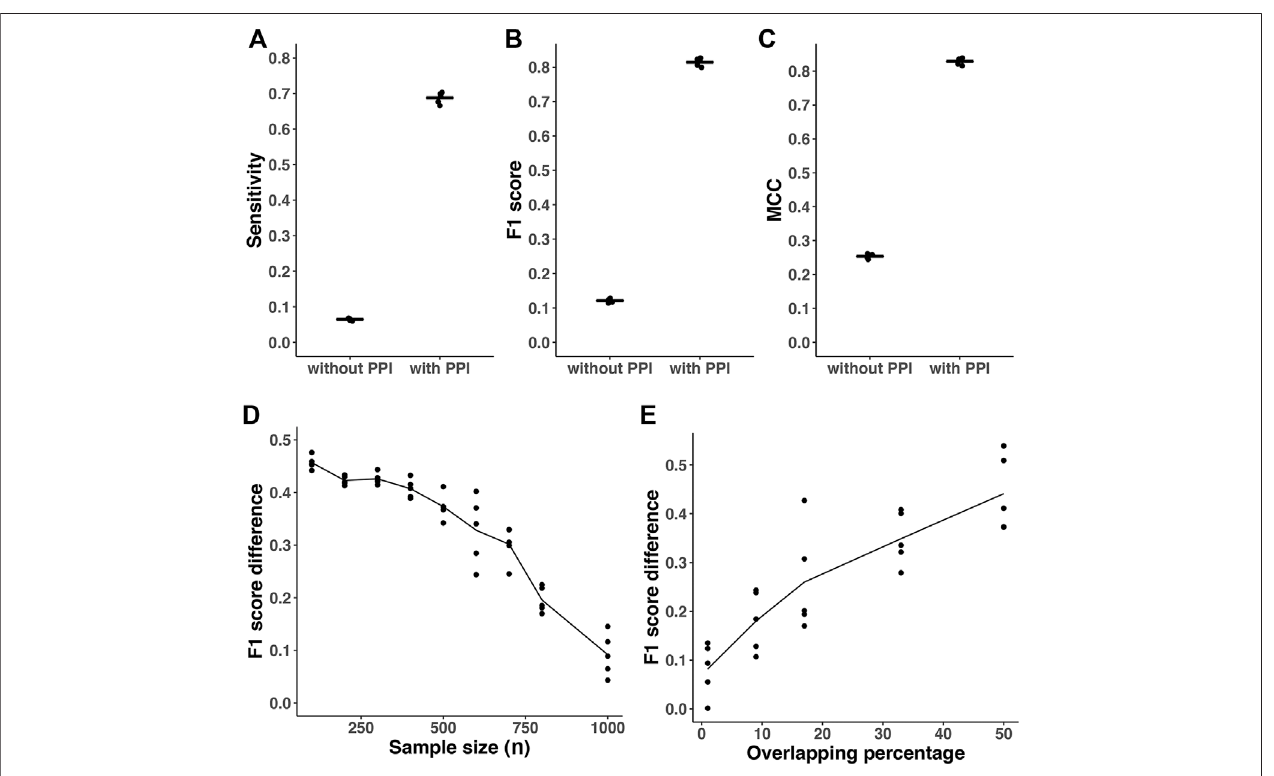
FIGURE 3 | Prediction accuracy comparison with or without incorporating prior information. All results are based on p (cid:1) 500 nodes and n (cid:1) 200. The density of simulated graph is around 2 % . The λ was optimized with cross-validation-based BIC (CV_BIC). The AhGlasso algorithm with the optimal λ s output the predicted networkswithorwithout incorporating priorknowledge. (A – C) Theoverlappingdegree betweenpriorinformationand thetarget true networkis80 % .Thesensitivity (A) , F1 score (B) , and MCC (C) were calculated based on theestimatednetworkand true network.For each simulation setting, thesimulations wererepeated 5 times. The bars represent the means of corresponding statistics metrics. Pair student ’ s t-tests were performed to compare the corresponding metrics. All p values < 0.0001. (D) ,theoverlappingdegreebetweenpriorinformationandtargettruenetworkis50 % .AvarietyofsamplesizesofdatawassimulatedasshowninX-axis.Thesimulation was repeated 5 times for each simulation setting. Y-axis represents the difference of F1 score between the outputs with or without prior knowledge. The lines represent the mean scores and the dots represent the results in each simulation. (E) , a variety of overlapping degree between prior information and target true network was simulatedasshowninX-axis.Y-axisrepresentsthedifferenceofF1scorebetweentheoutputswithorwithoutpriorknowledge.Thelinesrepresentthemeanscoresand the dots represent the results in each